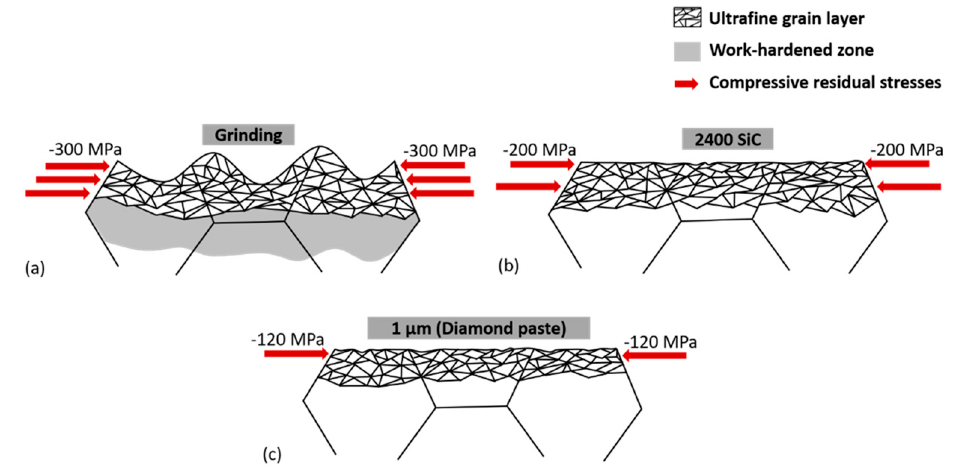
Figure 5. Schematics of surface modifications after mechanical surface treatment on 304L speci- mens, ( a ) grinding process, ( b ) polished samples down to 2400 with SiC, ( c ) polished samples down to 1 µm with diamond paste.